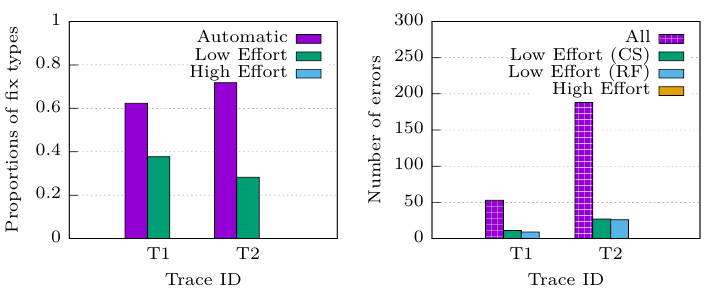
Figure 9: Number of disassembly errors resulting from baseband traces T1 and T2. Left: proportion of errors fixed automatically, errors fixed manually that are low effort, errors fixed manually that are high effort. Right: breakdown of errors; all errors reported, errors fixed: low effort where we create a function start (CS), where we force Ghidra to re-create a function (RF); high